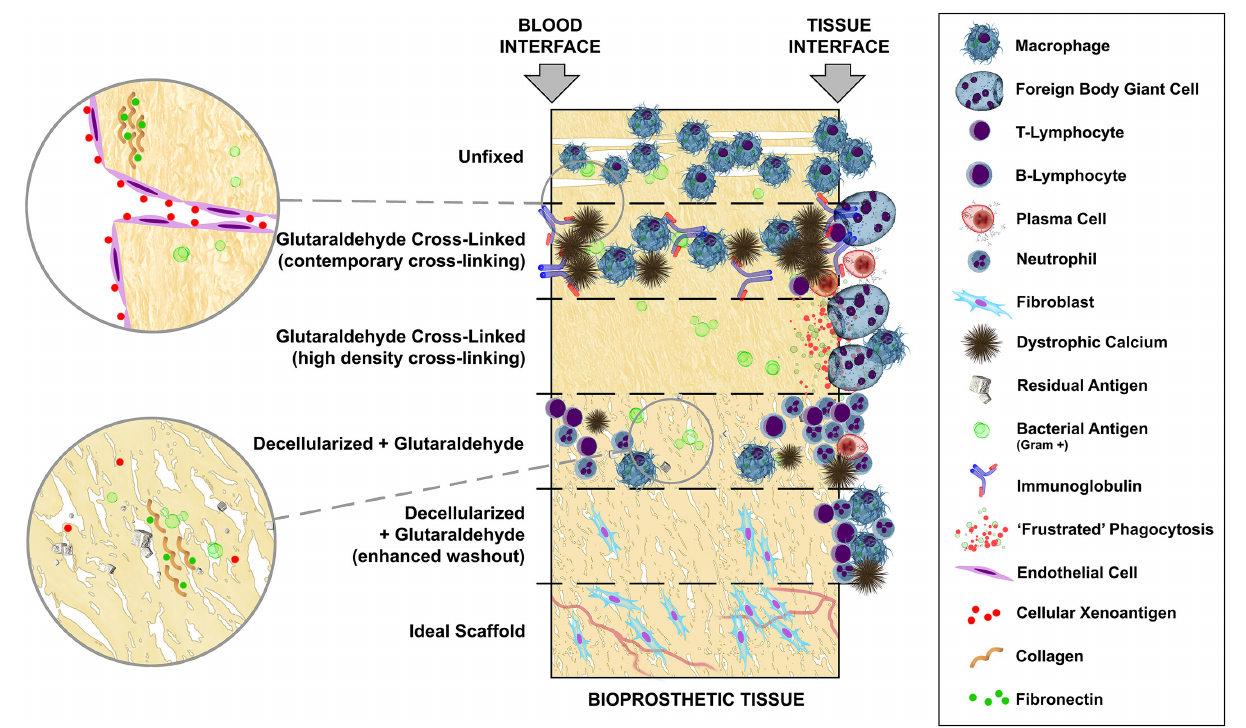
FIGURE 7 | Hypothetical mechanistic overview, based on animal models, of the potential impact of a residual immunogen presence on inflammatory and immune sequelae in bioprosthetic tissue and the ensuing potential for mineralization.